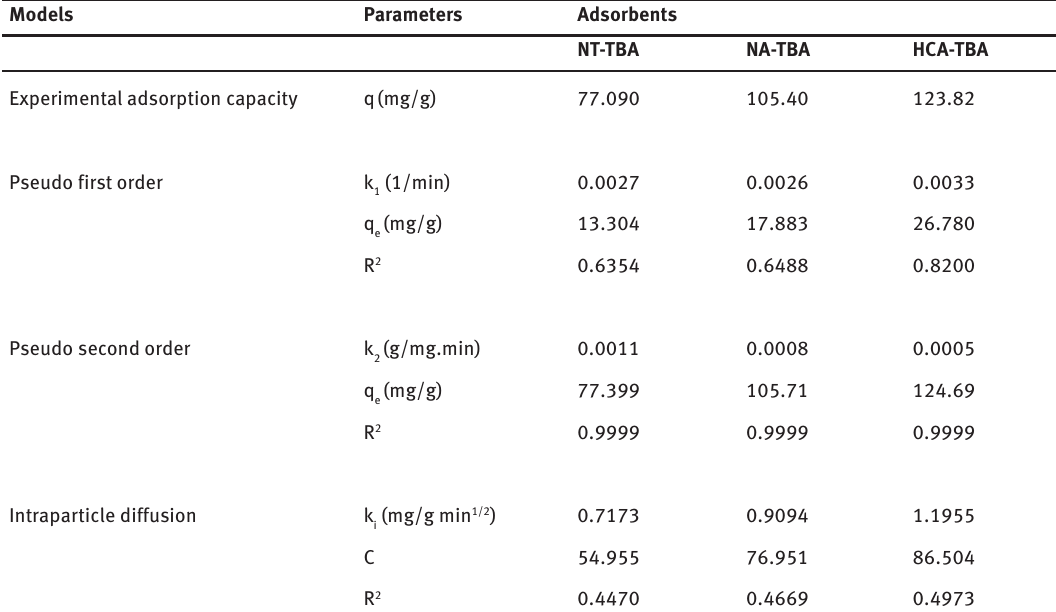
Table 2: Adsorption kinetics parameters for adsorption of Pb(II) by original and chemically pretreated TBP.